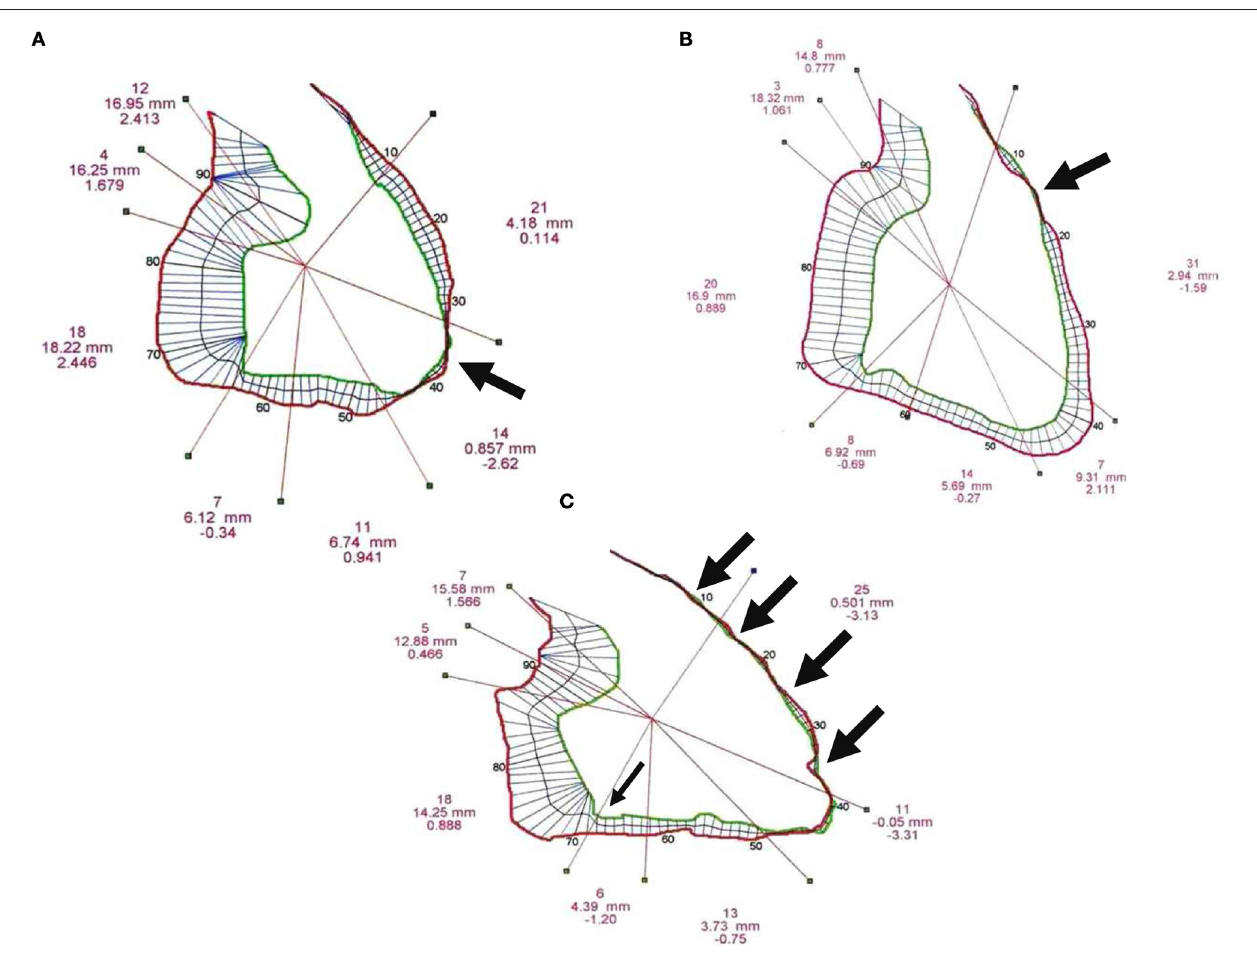
FIGURE 4 | Three typical examples of right ventricular (RV) segmental wall motion abnormalities observed in BrS group II. (A) Akinesia restricted to the RV apex (bold black arrow). (B) Hypokinesia or outpouching